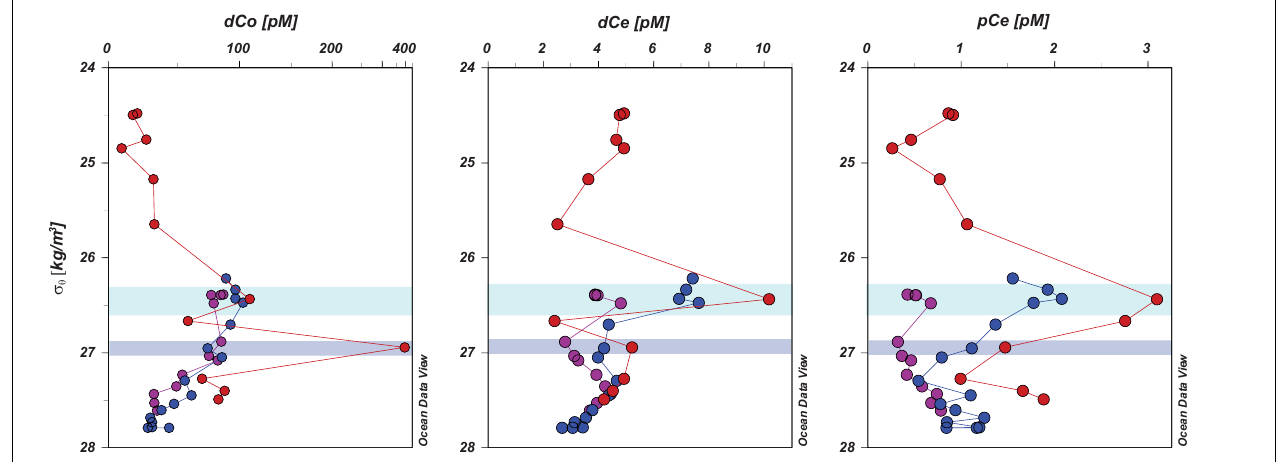
FIGURE 13 | Margin inputs of Co and Ce in the WSG: Elevated concentrations of dissolved and particulate Co and Ce in the 26.4 σ θ water mass resulting from lateral inputs from the nearby margin. Shaded areas show density ranges for the upper (green, 26.3–26.6 σ θ ) and lower (purple, 26.9–27.1 σ θ ) low temperature-low salinity